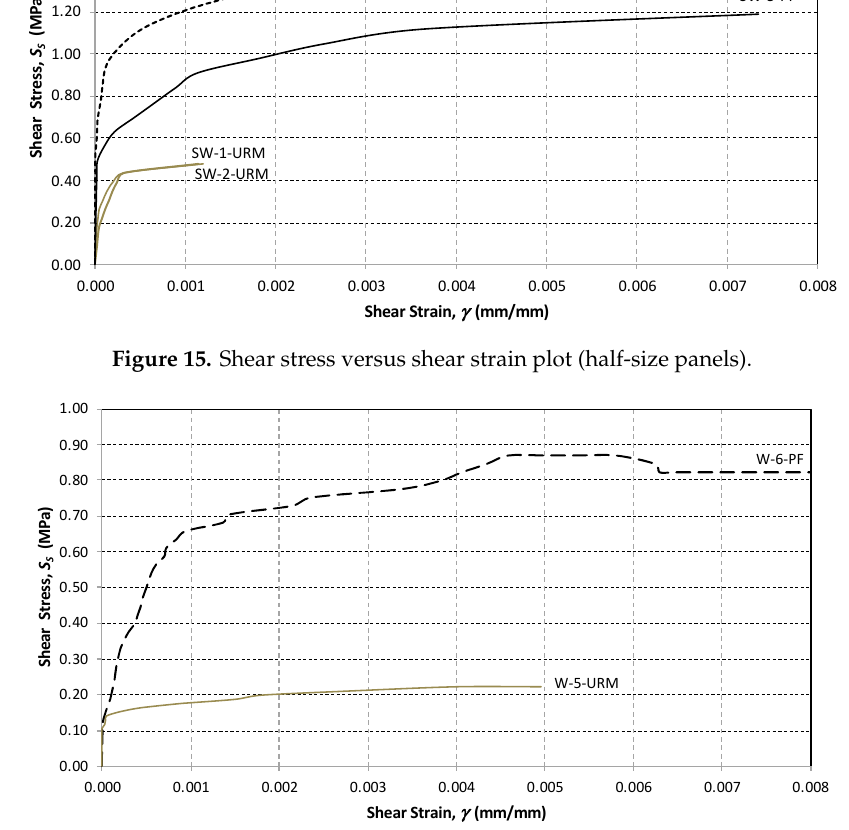
Table 5. Results of the shear tests (diagonal compression tests).